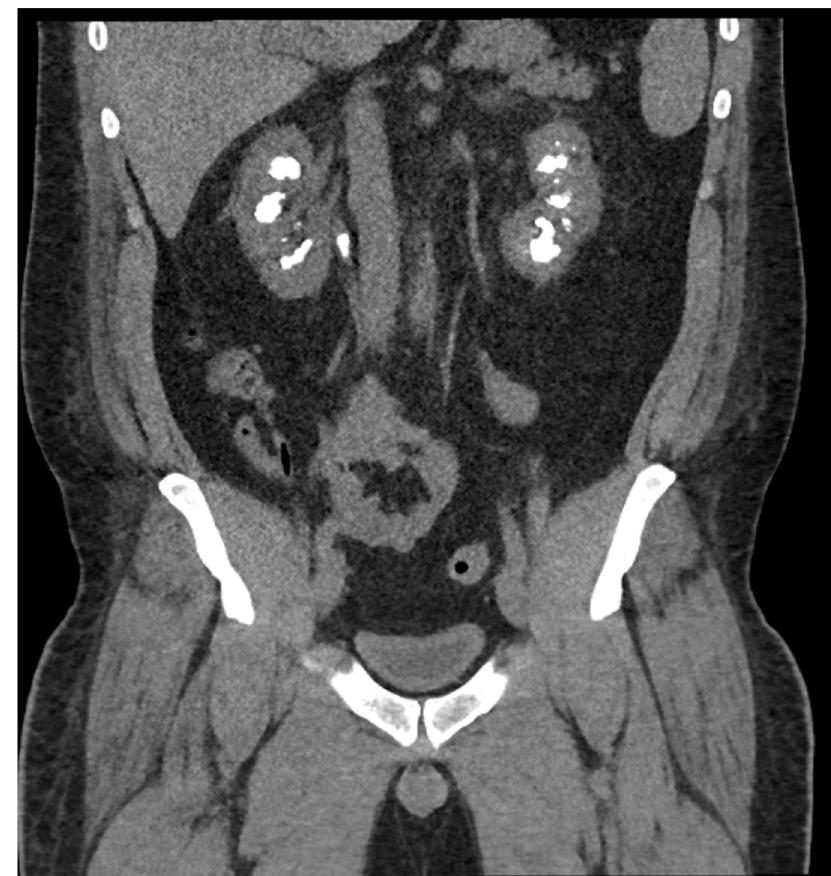
Figure 1. CT scan on presentation demonstrating bilateral large volume stone burden and an obstructing 1 cm right ureteropelvic junction stone. Burden of stone disease consistent with nephrocalcinosis. He underwent a standard (30 fr) right percutaneous nephrolithotomy in